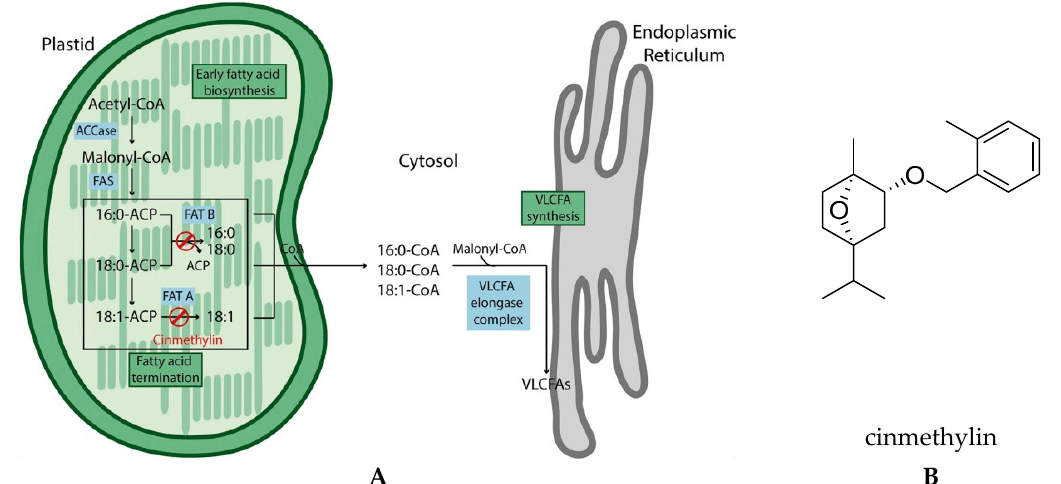
Figure 1. ( A ) Overview of fatty acid biosynthesis and herbicide targets in plant cells. Inhibition of acetyl-CoA carboxylase (ACCase) by haloxyfopmethyl or tepraloxydim disrupts early fatty acid biosynthesis. Cinmethylin prevents the release of both unsaturated and saturated fatty acids from the plastids through inhibition of fatty acid thioesterase (FAT) A and B, respectively. Inhibitors of very-long-chain fatty acid (VLCFA) biosynthesis act at the endoplasmic reticulum. ACP: acyl carrier protein; CoA: Coenzyme A. From [18] with permission. ( B ) Structure of cinmethylin.